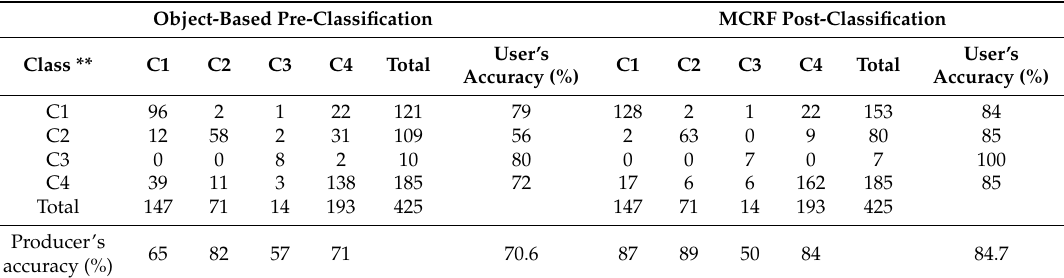
Table 4. Accuracy assessment for pre-classification and corresponding post-classification for the Yinchuan study area.